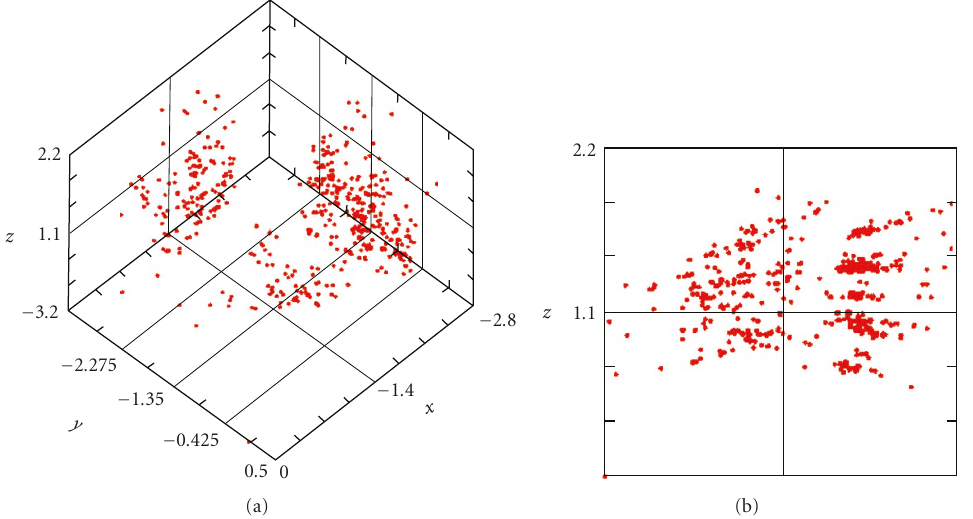
Figure 24: (a) Mapping using the SAD processor. (b) x - z plane of the map in